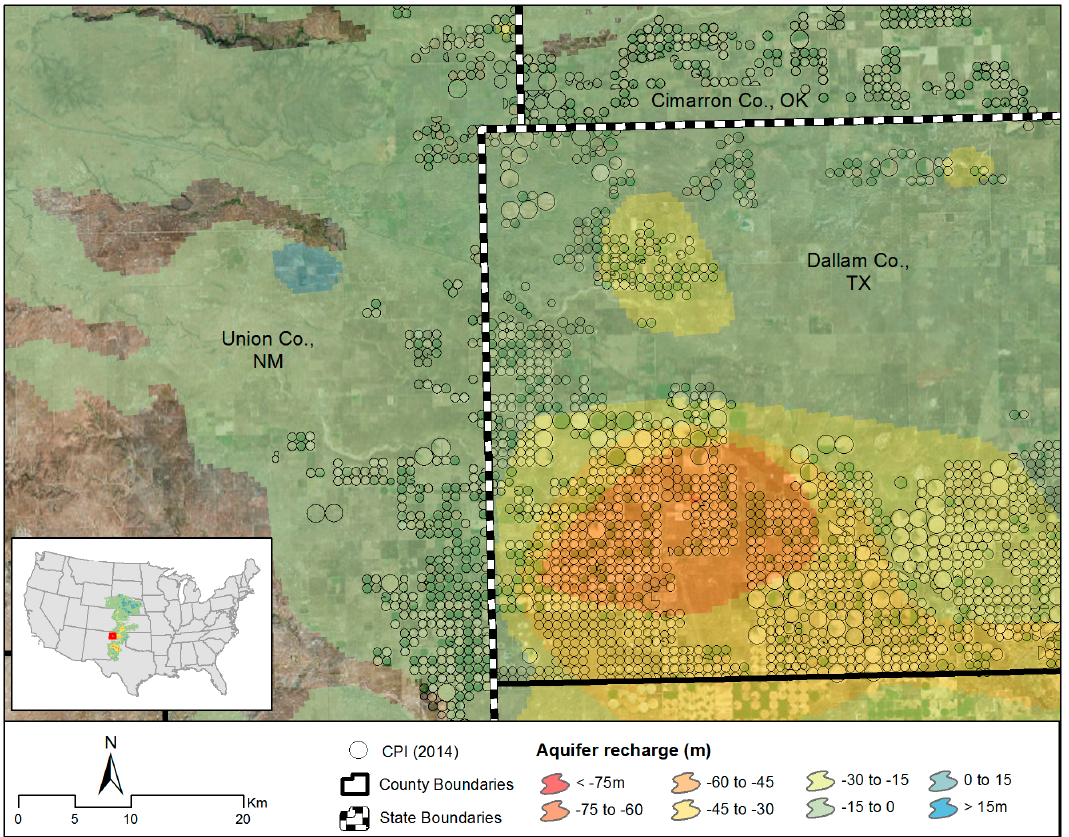
Figure 6. Groundwater recharge and drawdown with center pivot irrigation. Source: Figure created by the authors using aquifer data obtained from the U.S. Geological Survey